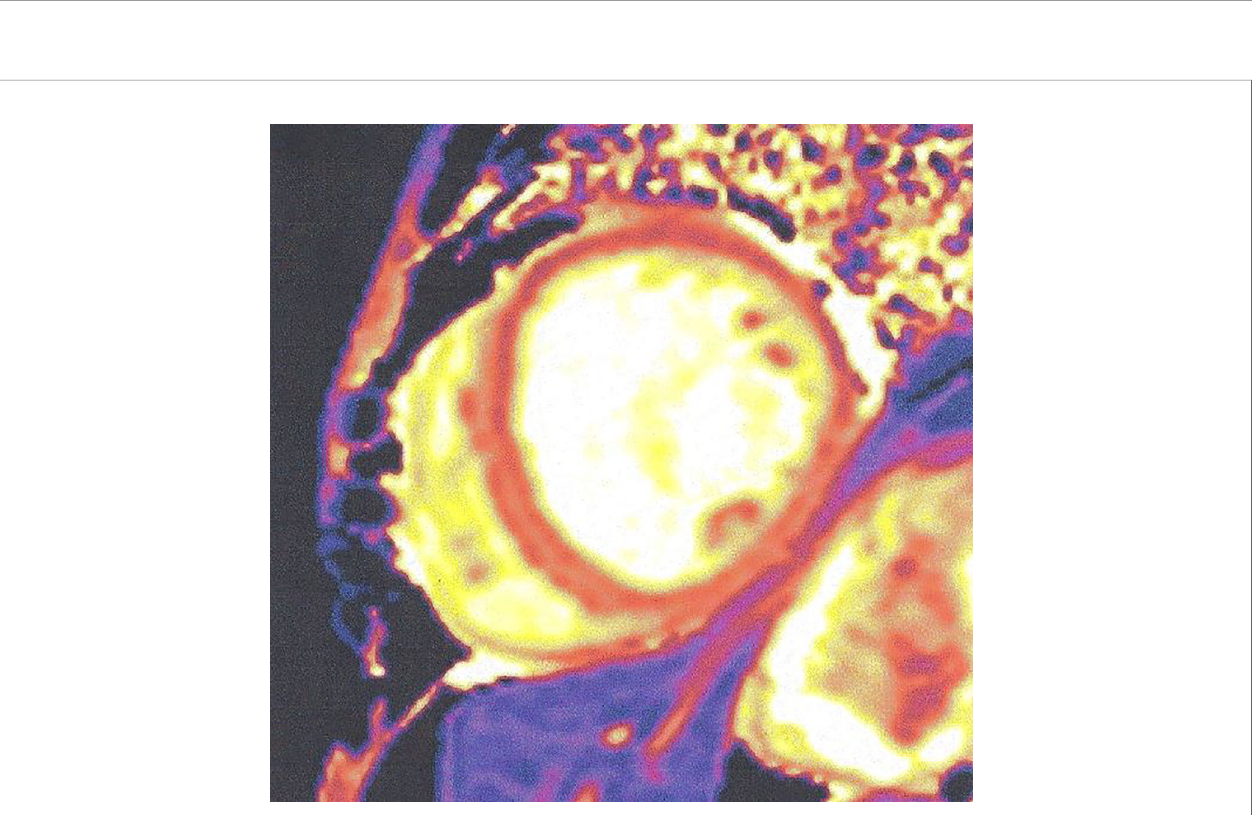
FIGURE 5 | Adenosine stress CMR image showing extensive perfusion defect in anterior and inferolateral wall of LV (dark area) in a patient with T2DM. This fi gure is original and based on data from Mavrogeni et al.